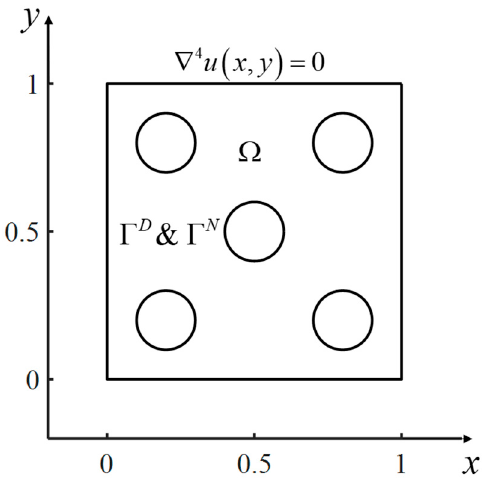
Figure 8. Schematic diagram of computational domain in case 4.